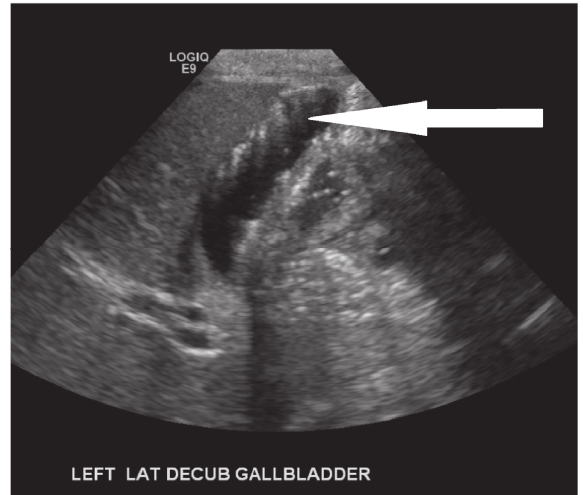
Figure 2: Biliary sludge and gravel of stones.